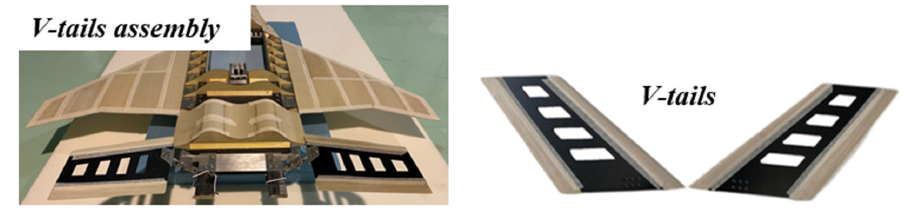
Figure 13. Structure and assembly of the V-tails.